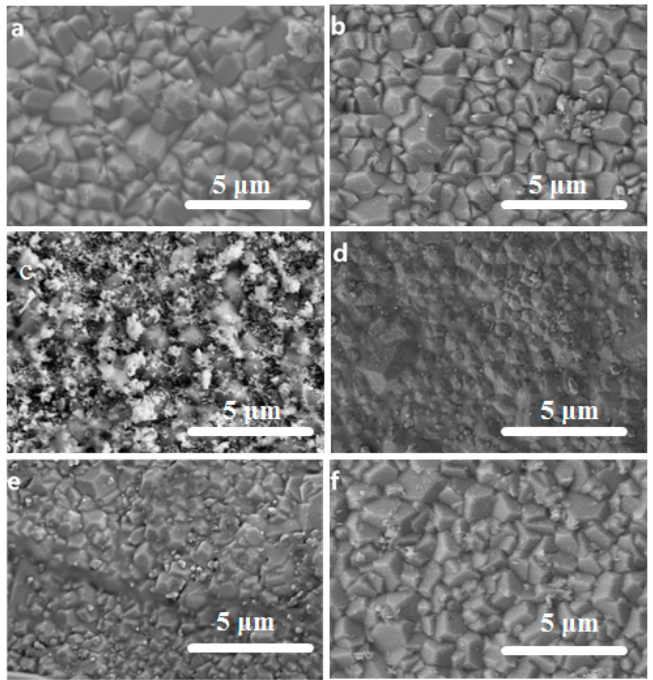
Figure 3. Scanning electron microscopy (SEM) images of NaA zeolite membrane ( a ) and its cation treated surface morphologies by ( b ) KCl, ( c ) AgNO 3 , ( d ) NH 4 Cl, ( e ) LiCl and ( f ) NaCl solutions.